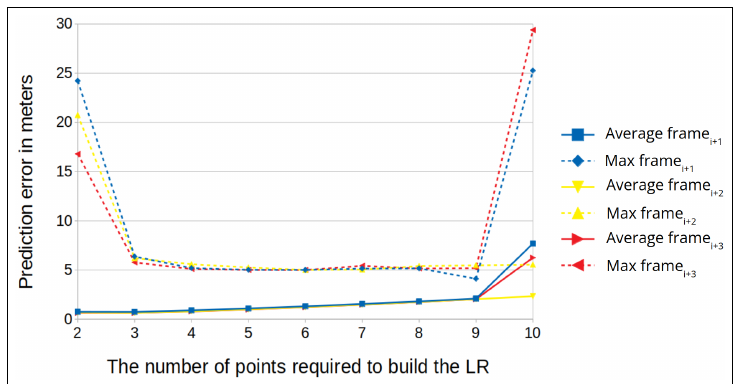
Figure 13. The prediction error (in meters) vs. various window sizes for an altitude of 100 m (average for the two